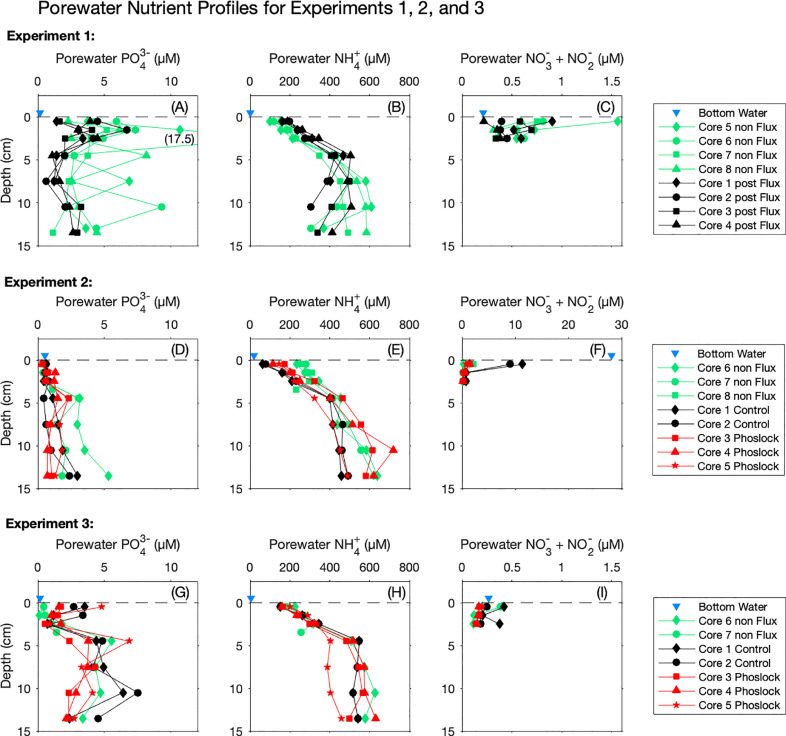
Porewater nutrient profiles of sectioned cores, separated by analyte (PO43−, NH4+, and NO3−+ NO2−) and Experiment (1, 2, and 3). non Flux (Green): Cores which were sectioned upon collection. Control (black): untreated cores which underwent flux incubations prior to sectioning. Phoslock (red): Phoslock® treated cores which underwent flux incubations prior to sectioning. Points are placed at the midpoint depth of each fraction. Many cores were longer than 15 cm, however only the first 15 cm are presented here. Bottom waters (blue triangle) are artificially given a depth of “−0.5 cm”. The sediment-water interface is indicated with a horizontal dashed line. Scales are consistent for each analyte, with the exception of (F), which has a different x-axis scale than (C) or (I).